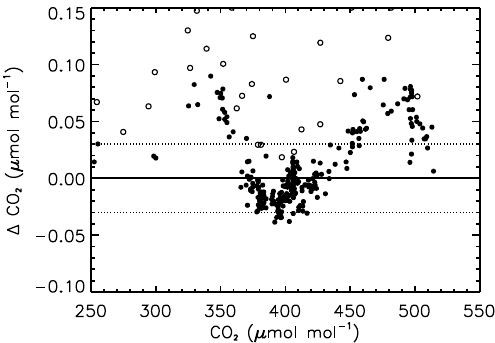
Figure 7. The laser spectroscopic CO 2 calibration system was run in parallel with the NDIR CO 2 calibration system for approximately 6 months. The differences (average NDIR − average laser spectro- scopic system) are plotted as a function of CO 2 . Typical repro- ducibility of the NDIR measurements ( ± 0.03, 68% CI) is shown with dashed lines. Highly depleted cylinders ( δ 13 C< − 20‰) are shown by open circles. These clearly indicate enhanced offsets due to the NDIR being somewhat sensitive to the isotopic composition differences between the samples and the standards used to calibrate the